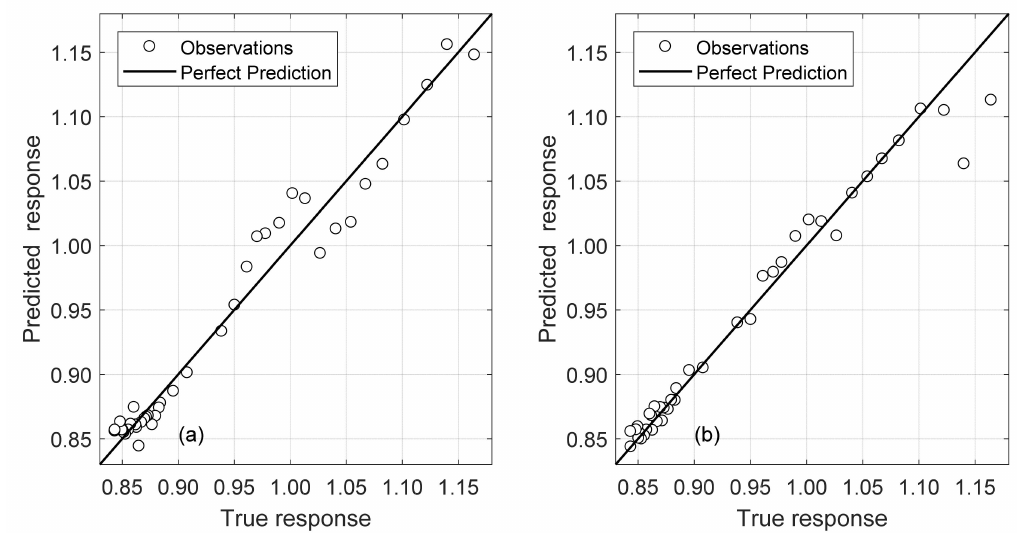
Figure 16. D1 Model Validation Predicted Vs Actual: ( a ) D1_SVM_F5_F6; ( b ) D1_GPR_F1_F6.